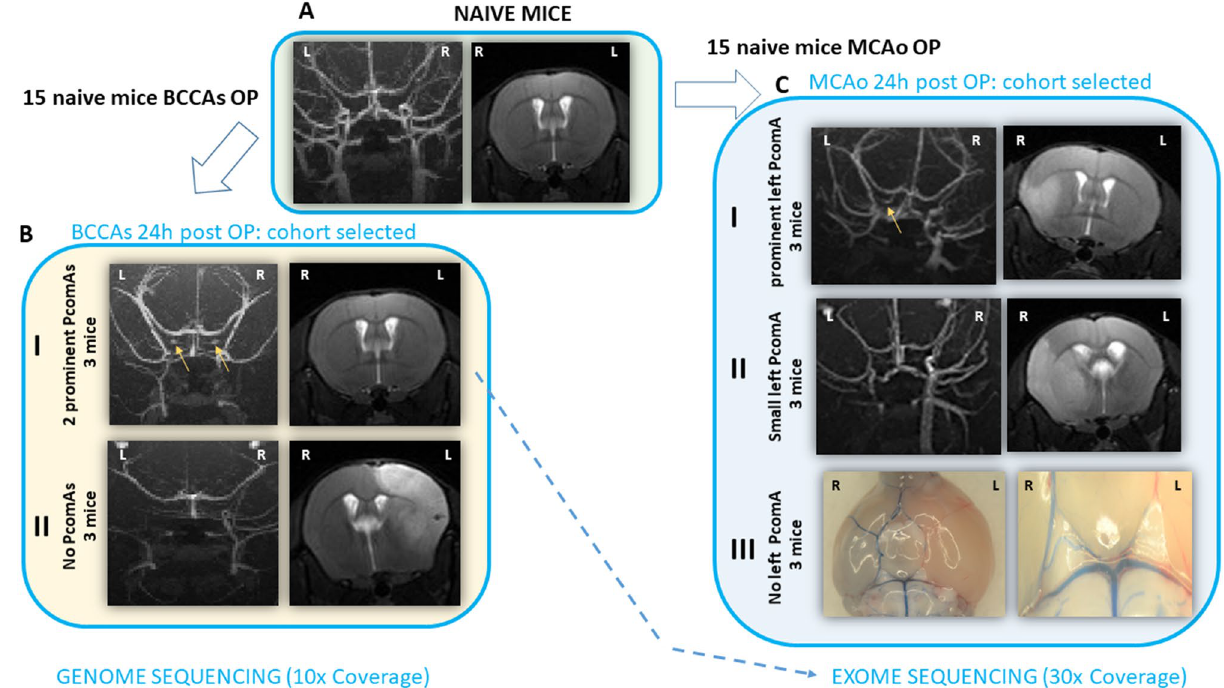
Figure 2. Pipeline used for the mouse cohort selection. Neuroimaging and vascular phenotypes of BCCAS and MCAO mice included in the study. Based on our previous studies with BCCAS and MCAO mice, we selected 2 cohorts of naive mice that underwent either the BCCAS or MCAO surgery ( A ). We then selected mice with extreme phenotypes in terms of PcomA patency based on the MRA, MRI and CBF measurement 24 h post surgery or, if not available (BCCAS mice with no PcomAs, dying a few hours post-surgery), based on histology. As expected and in line with our previous experiments we obtained 15% of mice with prominent PcomA(s), 25% of mice with non patent PcomA and the majority (60%) with small PcomA. Among these we then selected mice with extreme and dychotomic vascular phenotype. ( BI ) BCCAS mouse with two very prominent PcomAs (yellow arrows) and no ischemic lesions detectable on T2-weighted MRI. ( BII ) BCCAS mouse with no PcomAs, which developed a severe right hemispheric stroke and died 24 h after the surgery. ( CI ) MCAO mouse with left prominent PcomA (yellow arrow), which developed a small ischemic lesion (≈ 5% of the left hemisphere at 1 day) mostly affecting ventral areas (prefrontal cortex, striatum and ventral hippocampus). ( CII ) MCAO mouse with left small PcomA non detectable on MRA post-surgery, which developed a severe ischemic lesion (≈ 34% of the left hemisphere at 1 day) affecting also dorsal areas (orbital cortex and cerebellum). ( CIII ) MCAO mice with non-patent PcomA, which died between few hours and 2 days post surgery. R right, L left.